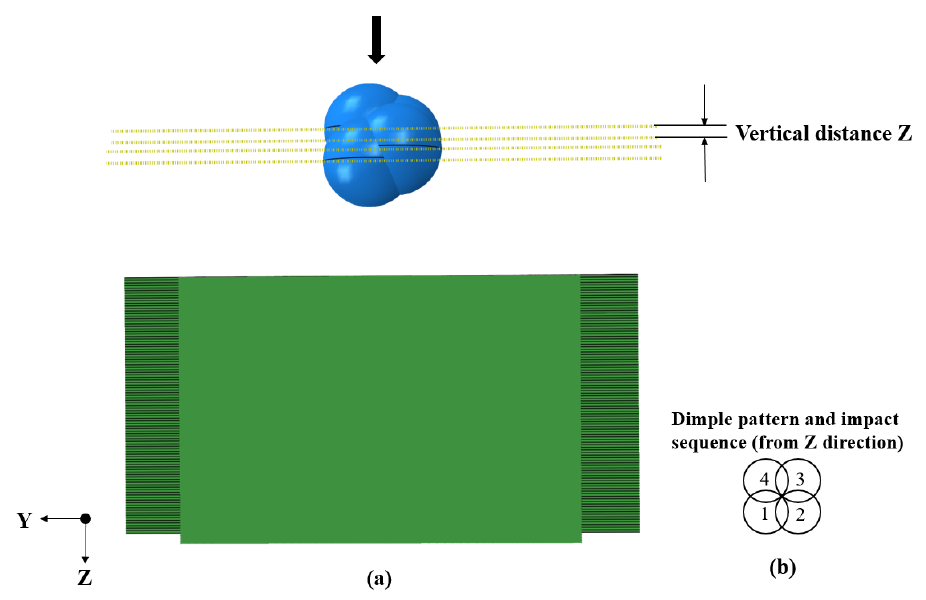
Figure 4. Schematic diagram of ( a ) the vertical distance between shots in 4-shots model; ( b ) the impacting sequence in 4-shots model.